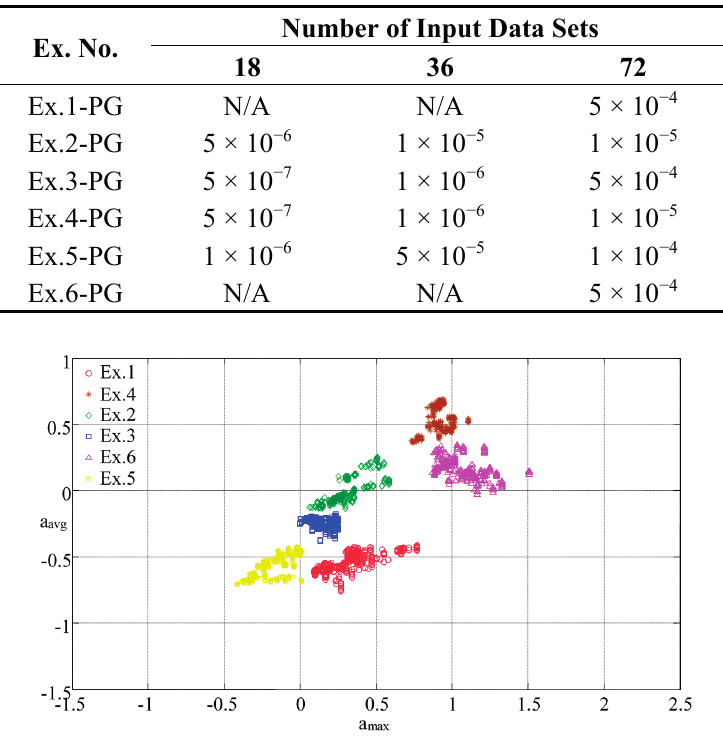
Table 2. Performance goal (PG) of each exercise at a stable recognition rate for different numbers of input data sets. ( N/A: Not available to completely reach stable recognition rate ).